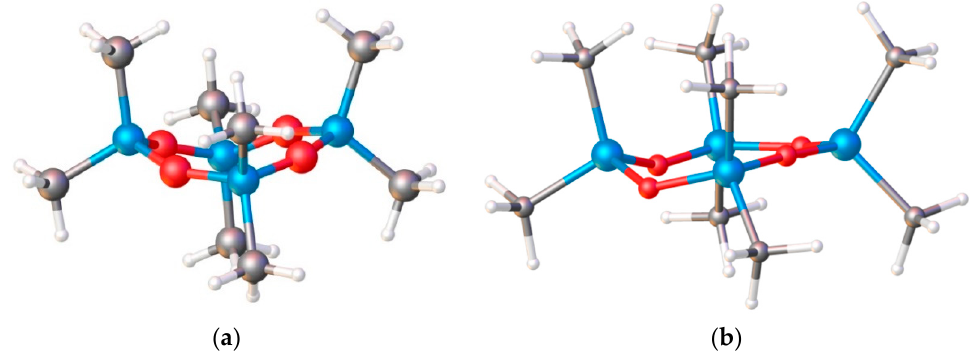
Figure 8. Transition state conformation of an isolated D4 molecule ( a ) and a conformation found in the local minimum by MD calculation ( b ). Color code: silicon—blue, oxygen—red, carbon—grey, hydrogen—white.